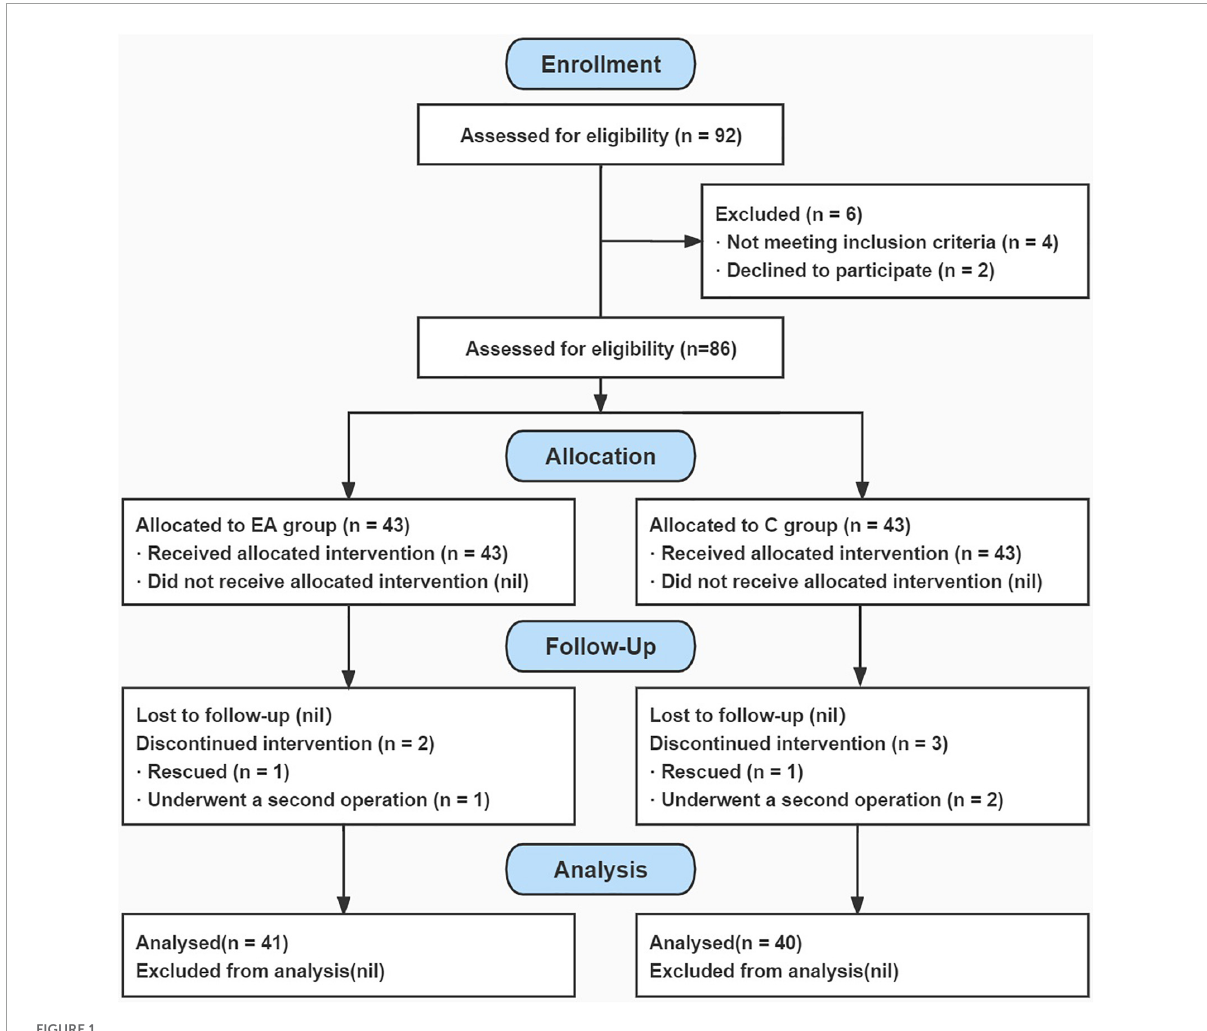
FIGURE1 Flowchart of the study process. EA, electroacupuncture; C,